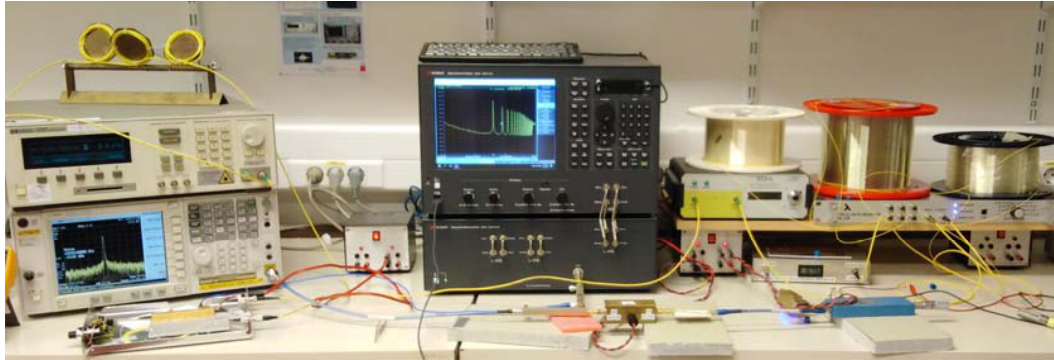
13 of 19 Figure 13. OEO application to measure the phase noise, SMSR and free spectral range ( FSR) of the electrical bandpass filters at different optical fiber lengths. Reprinted from Reference [100]. In the configuration shown in Figure 13, a spectrum analyzer (SA) is used to verify that the Barkhausan conditions are satisfied, and a signal source analyzer (SSA) is oper- ated to measure the phase noise, FSR and SMSR. The proposed application has the ad-